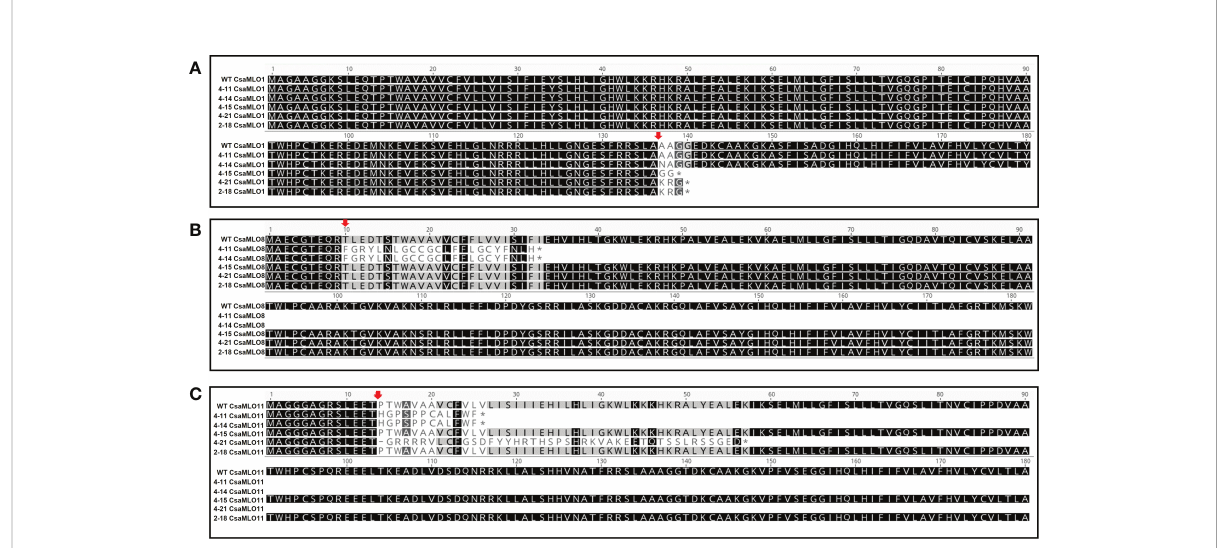
FIGURE 3 Amino acid alignment using sequences of mutants and WT plants. (A) When the deletions on the Cas9 cleavage (red arrow) cause stop codon formation on the 4-15 ’ s CsaMLO1 139th amino acid; the stop codon formation was detected on 2-18 and 4-21 CsaMLO1 ’ s 140th amino acid (3rd exon). The Alanine (A) was altered with Asparagine (N) at the 137 th amino acid as a result of the NHEJ caused by Cas9 cleavage at the gRNA1 target. (B) 2 bp deletions cause the unexpected stop codon formation on the 33 rd amino acid of CsaMLO8 in 4-11 and 4-14. The target site of gRNA2 was on the fi rst exon for CsaMLO8 and the changed amino acid structures are at the Cas9 cleavage (10 th aa) site for this gene. The early stop codon formation caused the loss-of CsaMLO8 function in 4-11 and 4-14. (C) The mutations seem to be responsible for the stop codon formation in CsaMLO 11 and stop codon ’ s positions of 4-11 and 4-14 ’ s CsaMLO11 closer to that gRNA3 than 4-15 and 2-18 CsaMLO11 . However, ORF shifts are initiated at gRNA3 position in whole CsaMLO11 del